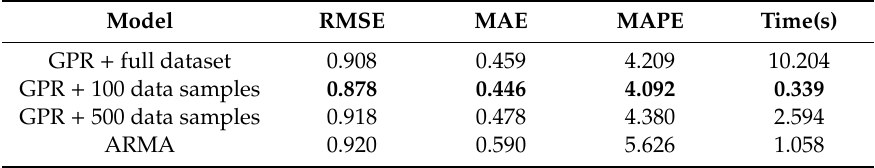
Table 1. Comparison of the proposed models built with two datasets in Y(1) prediction.